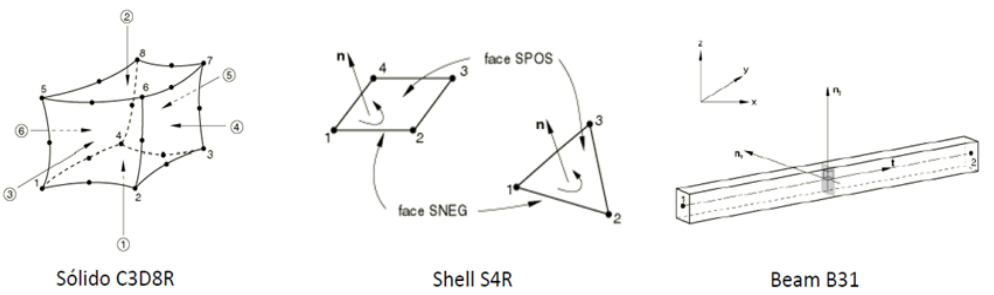
Figure 9. Element types (FE)